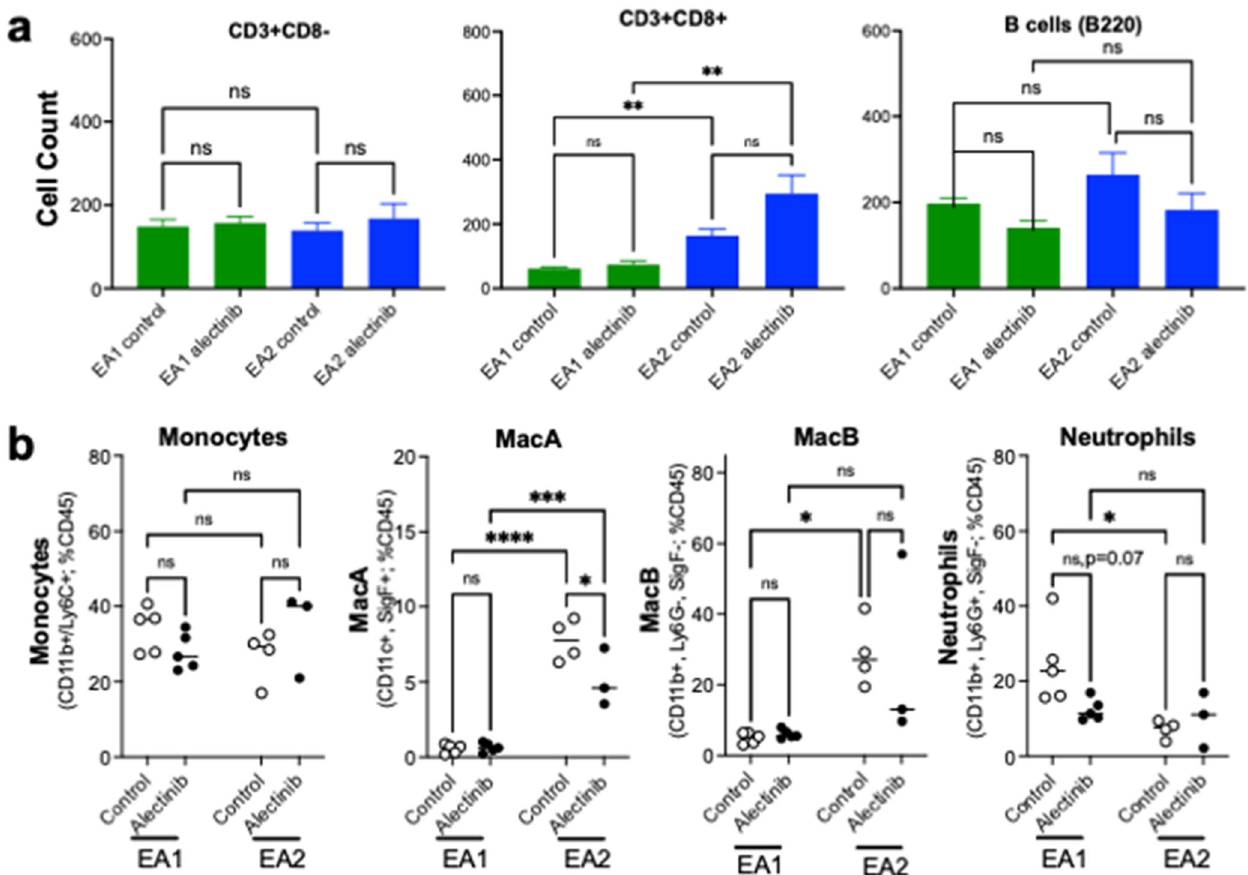
Fig. 4 Adaptive and innate immune cells in control and alectinib-treated EA1 and EA2 tumors. EA1 or EA2 cells were implanted in the left lung of C57BL/6 mice. Tumors were established for 3 weeks and then mice were treated for 4 days with either control or 20 mg/kg alectinib. a Tissue was harvested, processed, and FFPE slides were submitted to multispectral imaging using Vectra Polaris. Data acquisition, segmentation, and cell phenotyping was performed using inForm software. The R package Akoya Biosciences phenoptrReports was used to count CD3 + /CD8 + and CD3 + /CD8 − cells (presumed to be CD4 + T cells) as well as B220-positive B cells. Differences between groups was analyzed by the Kruskal-Wallis test with correction for multiple comparisons. b After 4 days of treatment, mice were sacri fi ced and a single-cell suspension was made from the left tumor-bearing lung. The single cell suspension was stained and submitted to fl ow cytometry analysis for innate immune cells using the previously described gating strategy 30 . Differences between groups were analyzed with ordinary one-way ANOVA and correction for multiple comparisons. Data are presented as the mean ± SEM where *, **, ***, and **** indicate p values <0.05, <0/01, <0.001, and <0.0001,